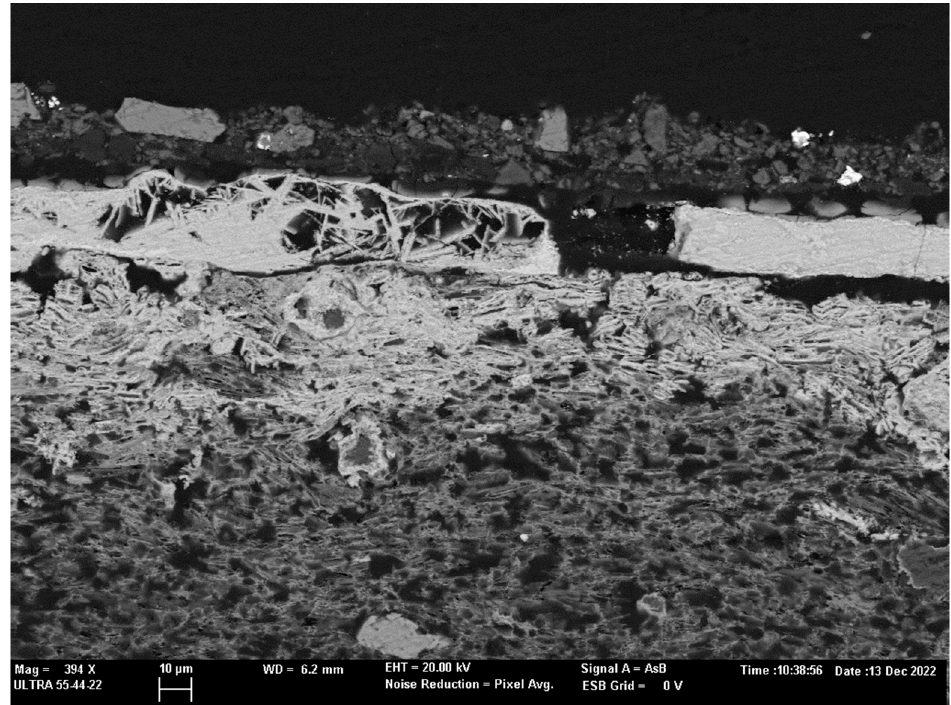
Figure 13. Backscattered electron image of the altered tin foil in sample J-2.